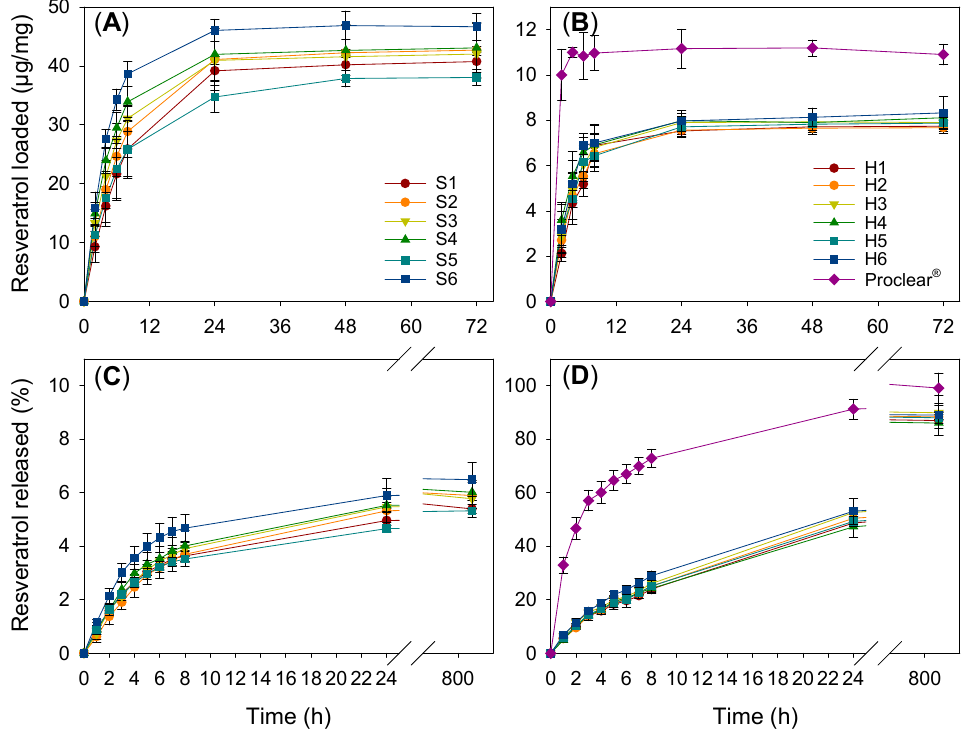
Figure 3. Resveratrol loading profiles for silicone ( A ) and HEMA ( B ) based hydrogels at 36 °C and 180 rpm for 72 h, and release profiles from silicone ( C ) and HEMA ( D )-based hydrogels in NaCl 0.9% medium at 36 °C.